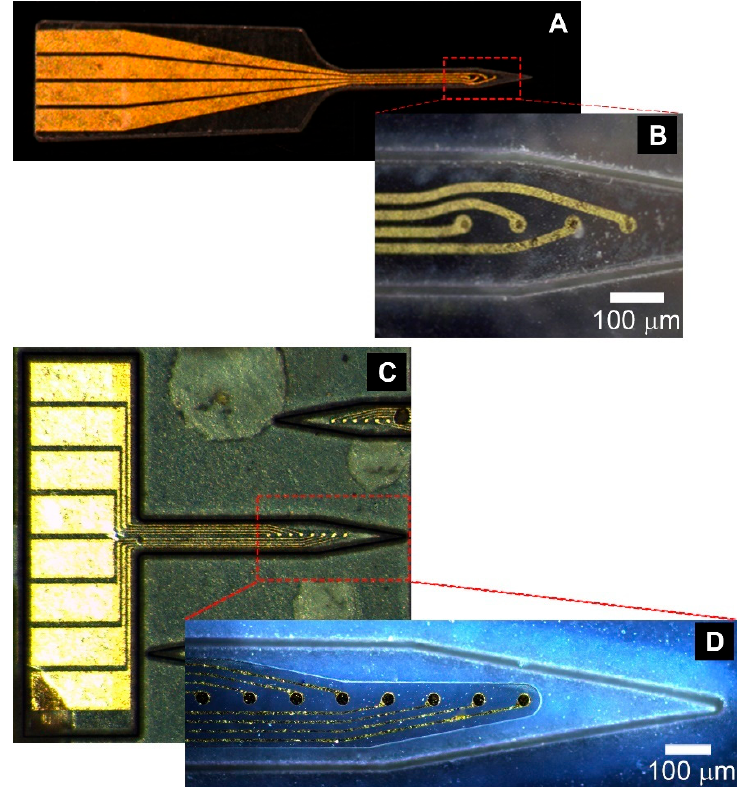
Figure 4. PVAc-CNC neural probes: ( A ) 4-channel probe overview; ( B ) Close-up of 15 µm-diameter Au microelectrode sites on 4-electrode probe; ( C ) 8-channel probe overview; ( D ) Close-up of 30 µm-diameter Au microelectrode sites on 8-electrode probe.